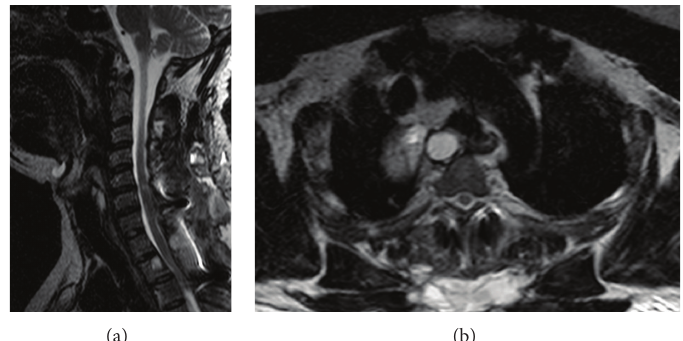
Figure 4: T2 images sagittal and axial planes (a) and (b) show the placement of a vertebral spacer, the successful decompression of the spinal cord, and a residual tissue in the chest on the right.